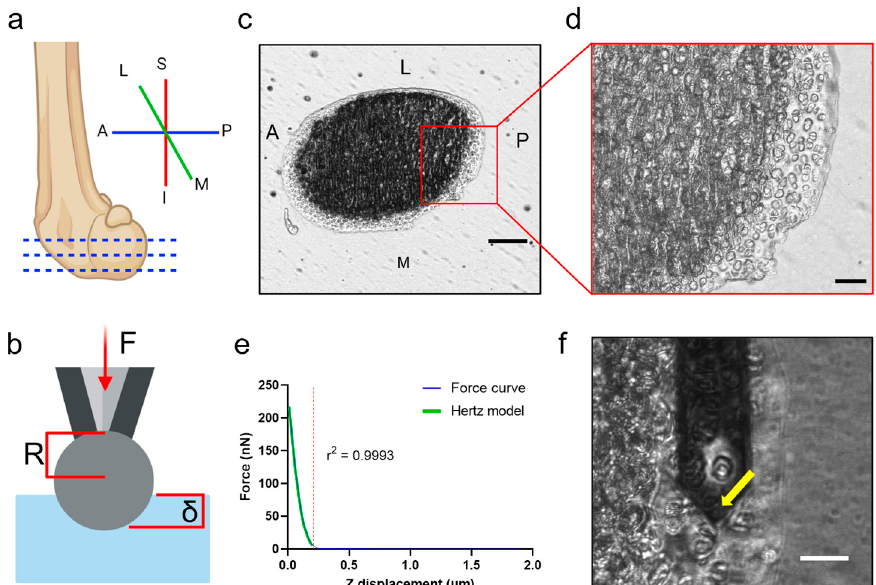
Figure 2. Graphics of the AFM process on articular cartilage. ( a ) Orientation of murine femora for AFM embedding. Samples are sectioned in the transverse plane, cutting from the posterior edge as indicated by dotted blue lines. ( b ) Graphic illustration of a spherical AFM probe indenting a material. F = indentation force, R = tip radius, δ = indentation depth. ( c ) A representative section of a distal femoral medial condyle. A (anterior), P (posterior), M (medial), and L (lateral). Scale bar = 200 µm. ( d ) Magnified section of articular cartilage on the surface and subchondral bone. Scale bar = 50 µm. ( e ) Indentation graphs were analyzed by Hertzian model fit. This fit covers the linear region of the curve by maximizing the r² value, including at least 80% of the data. ( f ) Image taken during AFM micro-indentation. This mode allows visualization of the sample under the microscope. Scale bar = 25 µm. The AFM tip is at the end of the yellow arrow. Note that the AFM head obscures the view of the entire sample in this setting.